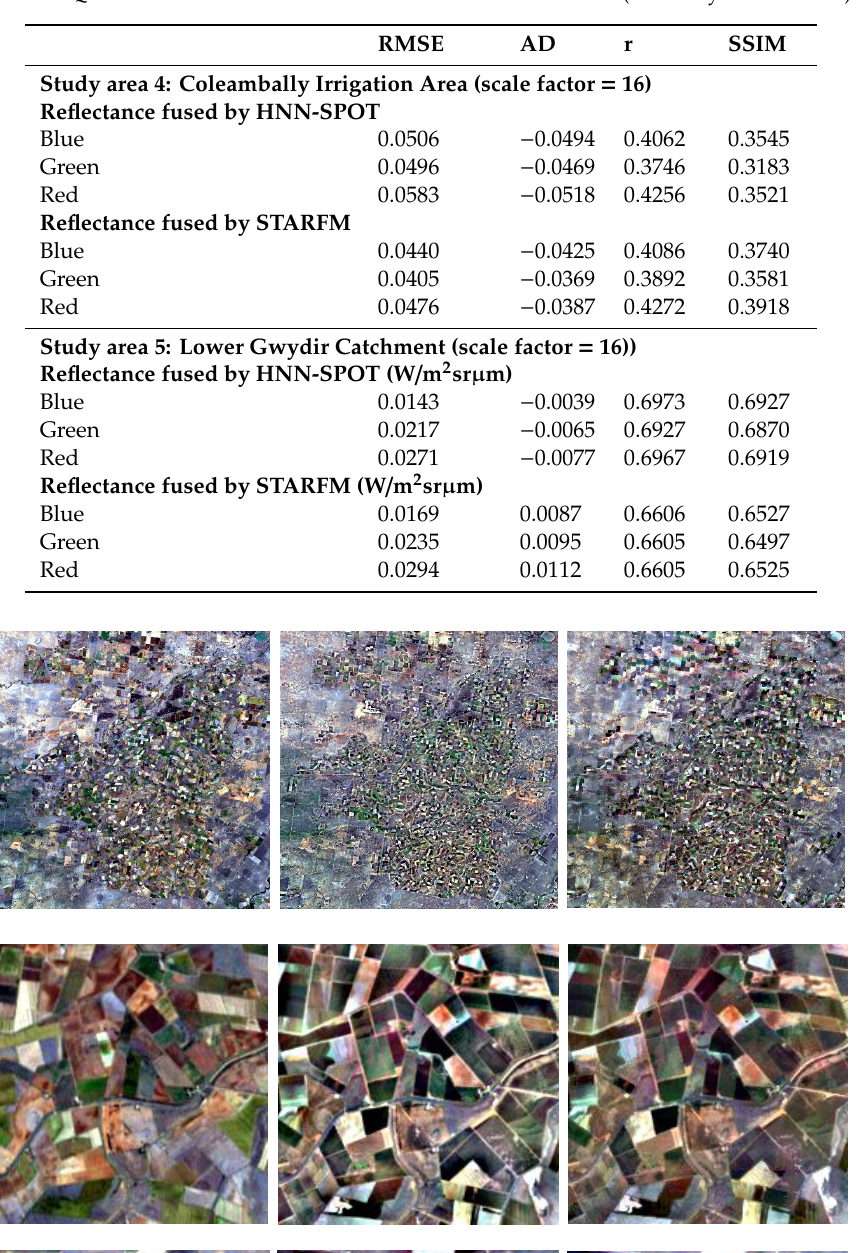
Table 4. Quantitative assessments on HNN-SPOT and STARFM (for study area 4 and 5).